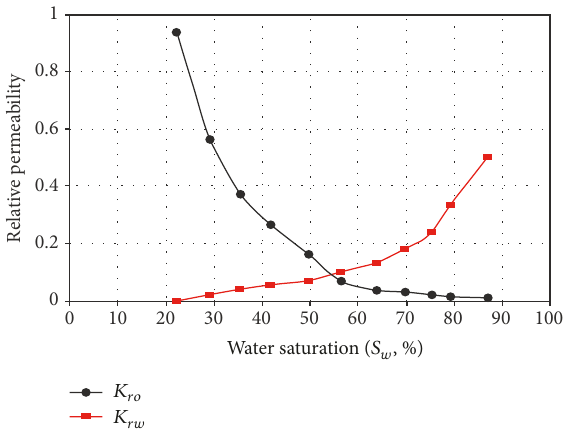
Figure 4: Relative permeability curve between crude oil and water.